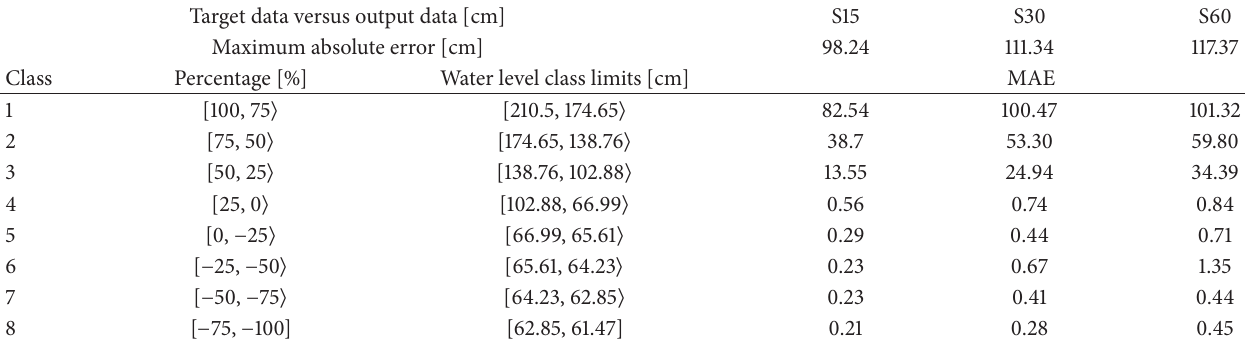
Table 5: Performance statistics of the ANN model during evaluation: mean absolute error (MAE) for the data